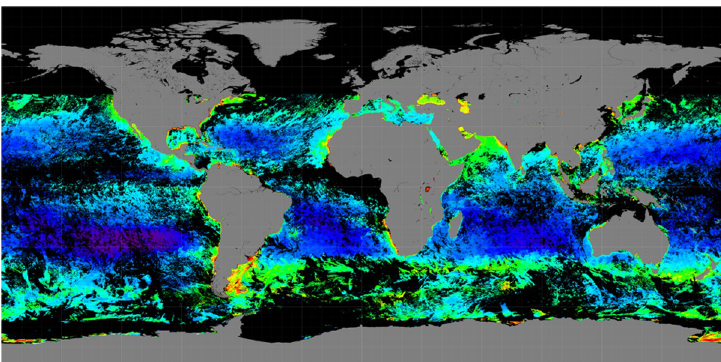
Fig 2. Level-3 data for the chlorophyll a concentration from Dec. 27 to Dec. 31, 2015 [40]. Dark regions indicate missing values.